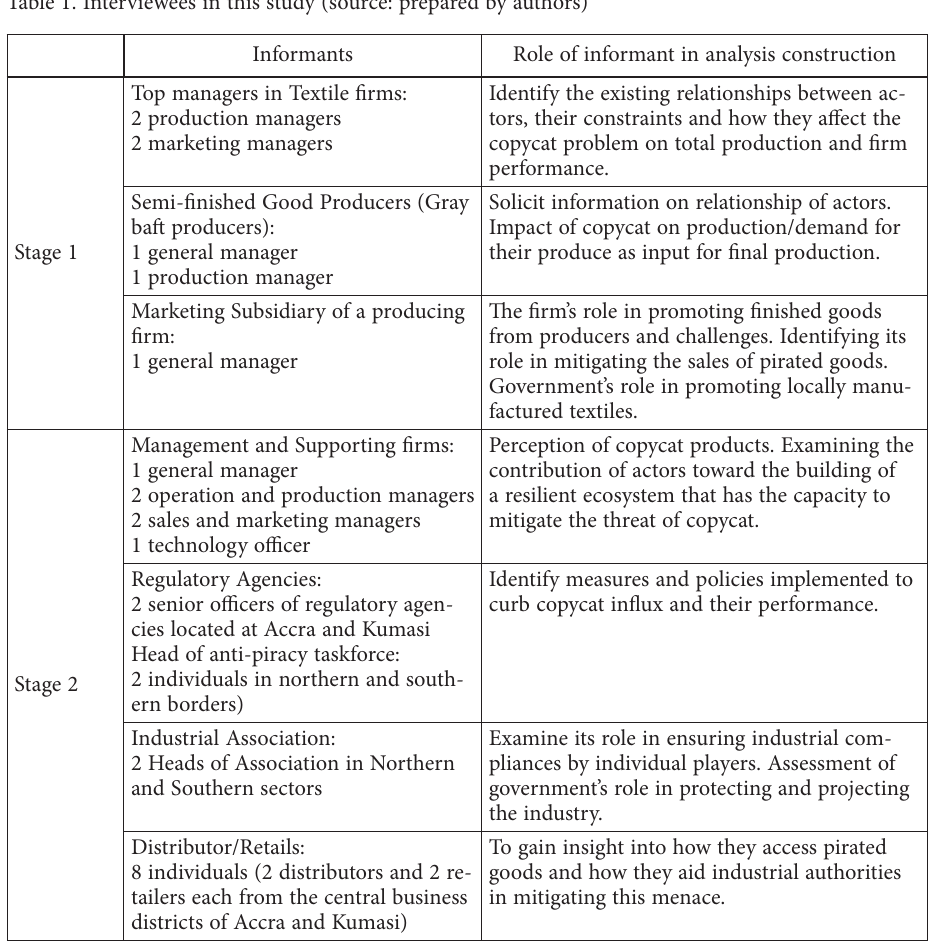
Table 1. Interviewees in this study (source: prepared by